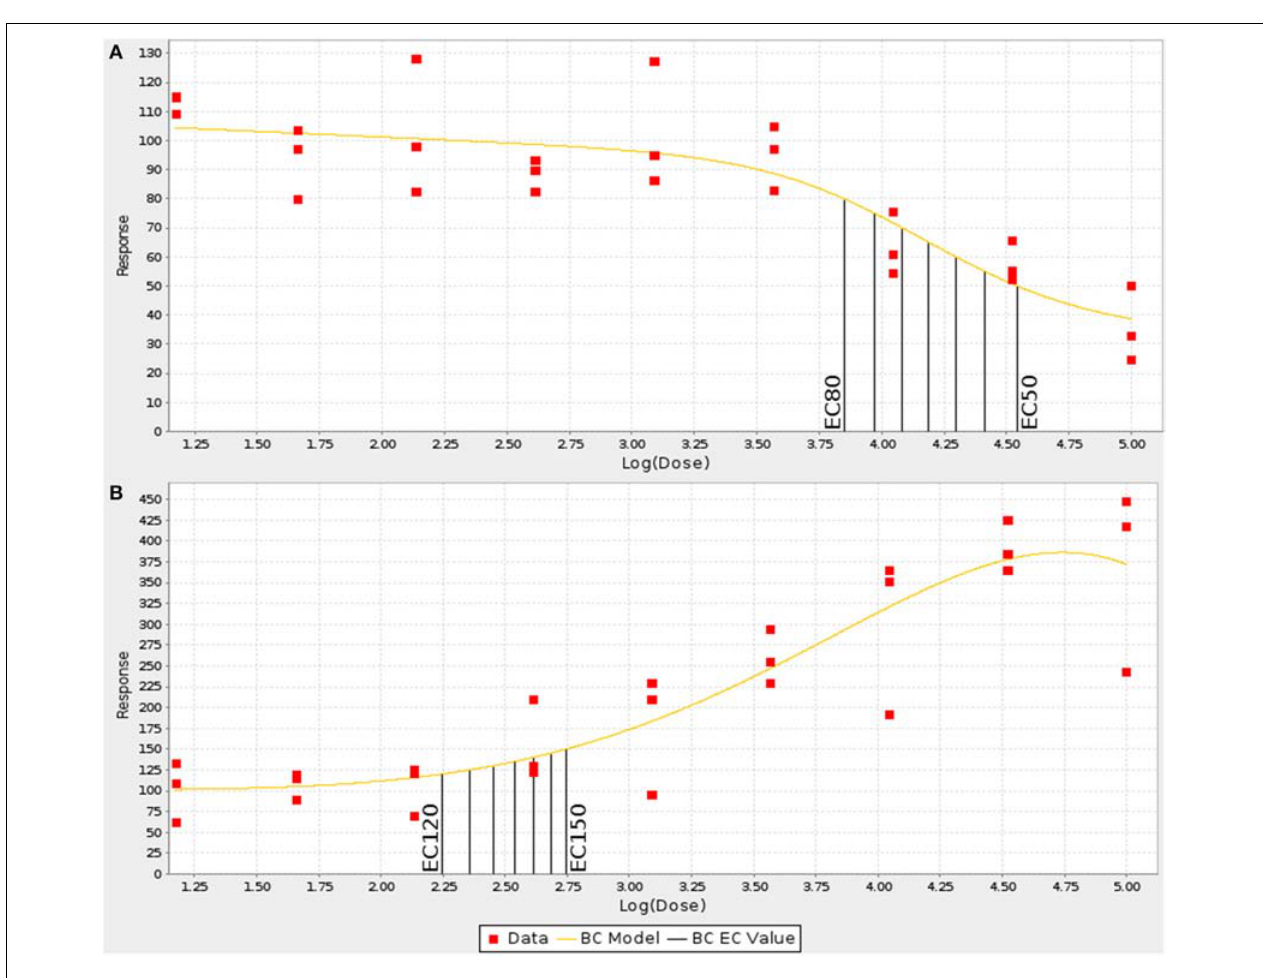
defined intervals. (A) For decreasing responses, EC 50 –EC 80 were calculated in 5% steps. (B) For increasing values, EC 120 –EC 150 were calculated in 5%